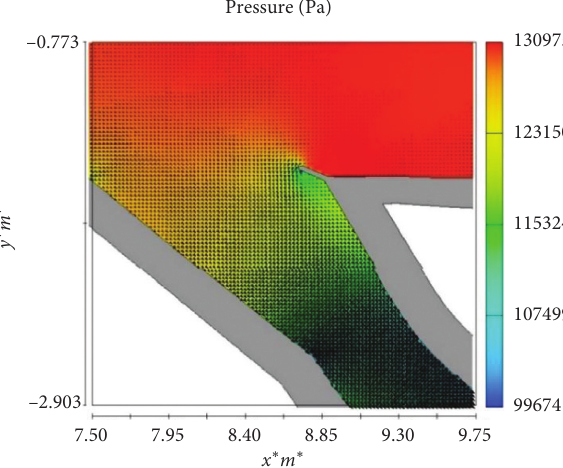
Figure 29: Pressure changes in the bottom outlet’s branch area of the Sardab Dam for a fully closed gate and 100% open branch valve.